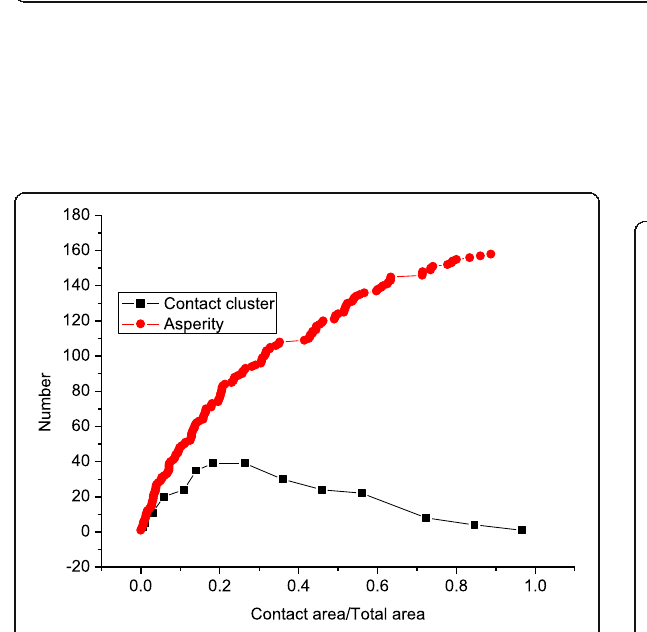
Fig. 4 Surface valleys and cluster number under different contact areas Fig. 5 The cluster development for different